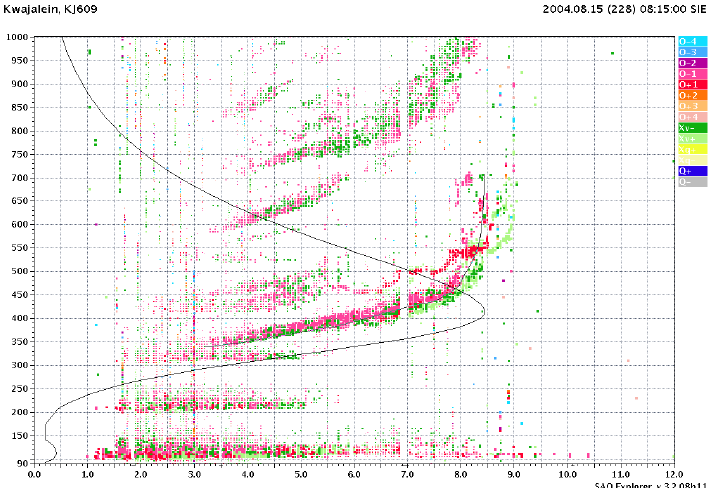
Fig. 11. Kwajalein ionogram from 15 August 2004, 08:15 UT. The F layer trace is extensively bifurcated and clearly a separate or secondary trace. The brighter red color of the second trace is indication of positive Doppler shift, distinctly different from the consistently negative Doppler shift of the primary